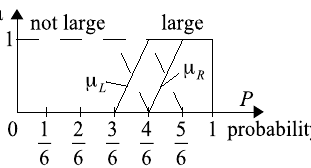
Figure 1. Uncertainty of the borders of the membership function of the fuzzy concept “large